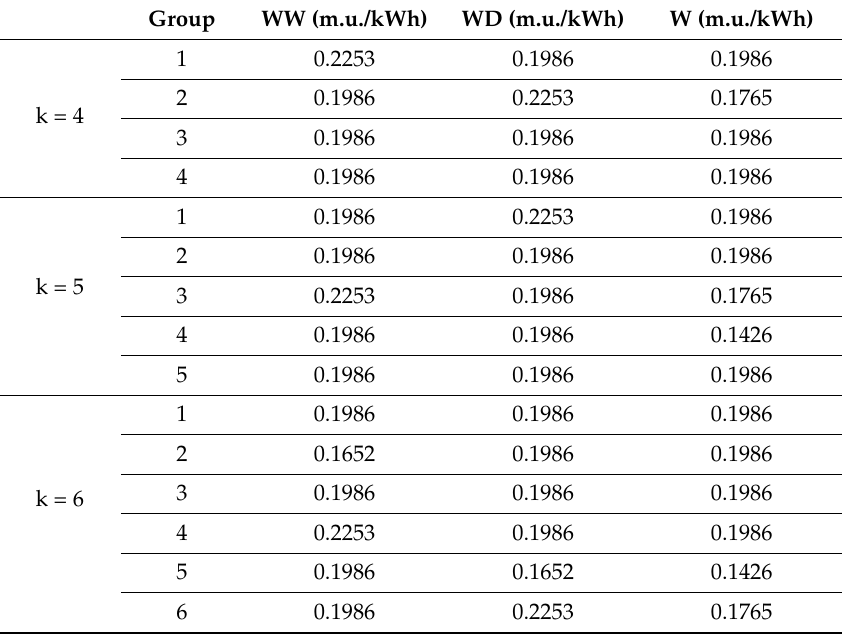
Table 6. Tariffs definition for k = 4 to k =